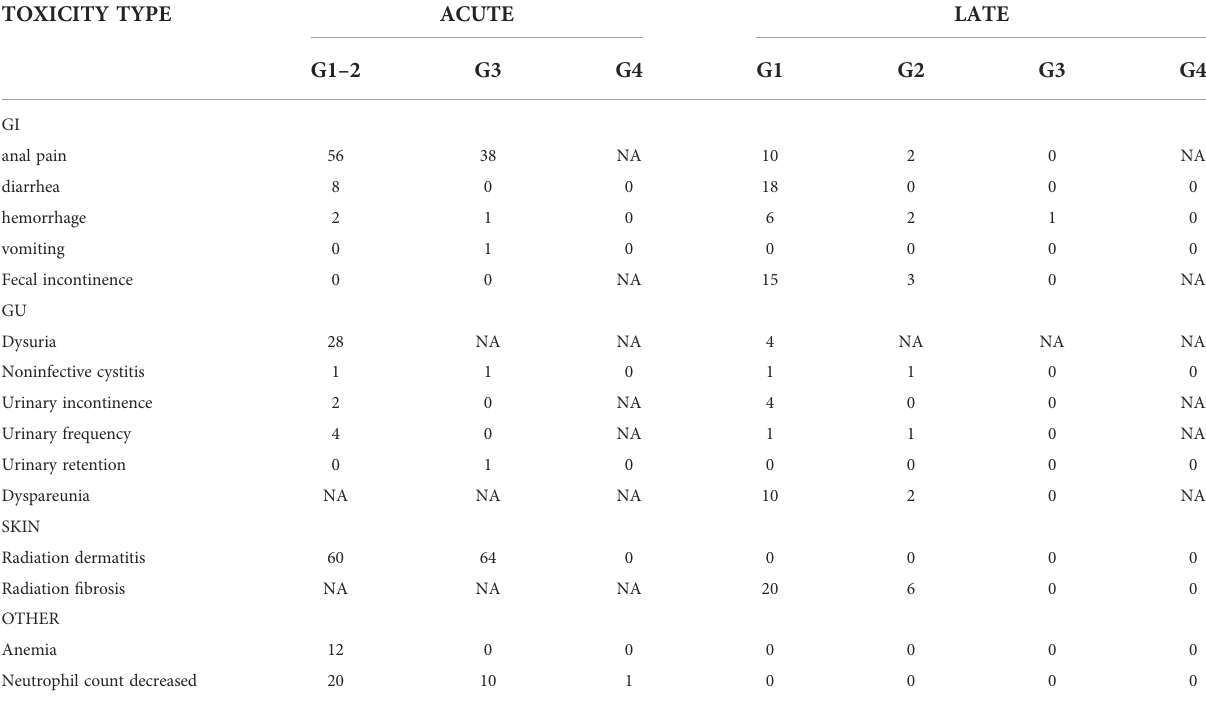
TABLE 3 Maximum acute and late